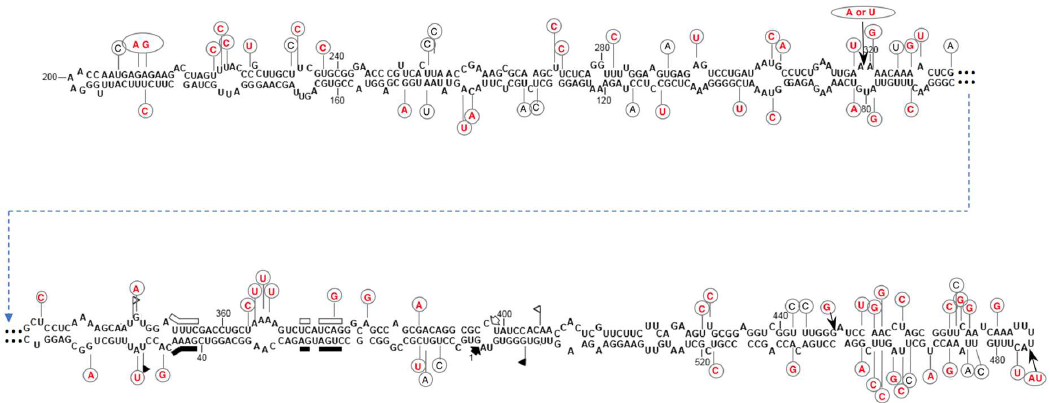
Figure 3. Primary and predicted secondary structures of lowest free energy of CtaHVd-LR1 refer- ence variant (accession number OP418121). Regions involved in the formation of (+) and (−) HHRz structures and the respective self-cleavage sites are indicated by flags and thick arrows, respectively, with bars demarking the nucleotides conserved in most natural hammerhead structures. Filled and open symbols refer to (+) and (−) polarity, respectively. Polymorphic positions identified in the mul- tiple alignment with the other cloned variants are indicated by circles containing the mutated nu- cleotide. Nucleotide changes preserving the proposed rod-like secondary structure are in red, with insertions marked by thin arrows. In the proposed rod-like structure, the central region contains the HHRzs of the two polarity strands that were located one in front of the other. Interestingly, most polymor- phic positions did not modify the proposed rod-like secondary structure because they were co-variations, conversions of canonical into wobble base-pairs or were located into loops (Figure 3). It is worthy of note that several polymorphic positions map to the central hammerhead region (see below). Altogether, data on the sequence variability of CtaHVd- LR1 populations preserving the predicted rod-like secondary structure suggest a major role of this structural feature for its survival.